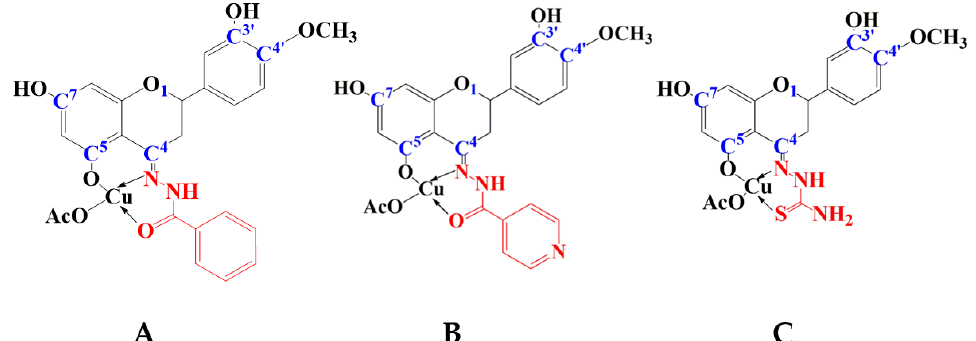
Figure 1. Structure of ( A ) ( E )-acetoxy((4-(2-benzoylhydrazono)-7-hydroxy-2-(3-hydroxy-4-methoxyphenyl)chroman-5-yl)oxy)copper; ( B ) ( E )-acetoxy((7-hydroxy-2-(3-hydroxy-4-methoxyphenyl)-4-(2-isonicotinoylhydrazono)chroman-5-yl)oxy)copper (CuHIN); ( C ) ( E )-acetoxy((4-(2-carbamothioylhydrazono)-7-hydroxy-2-(3-hydroxy-4-methoxyphenyl)chroman-5-yl)oxy)copper (CuHTSC).